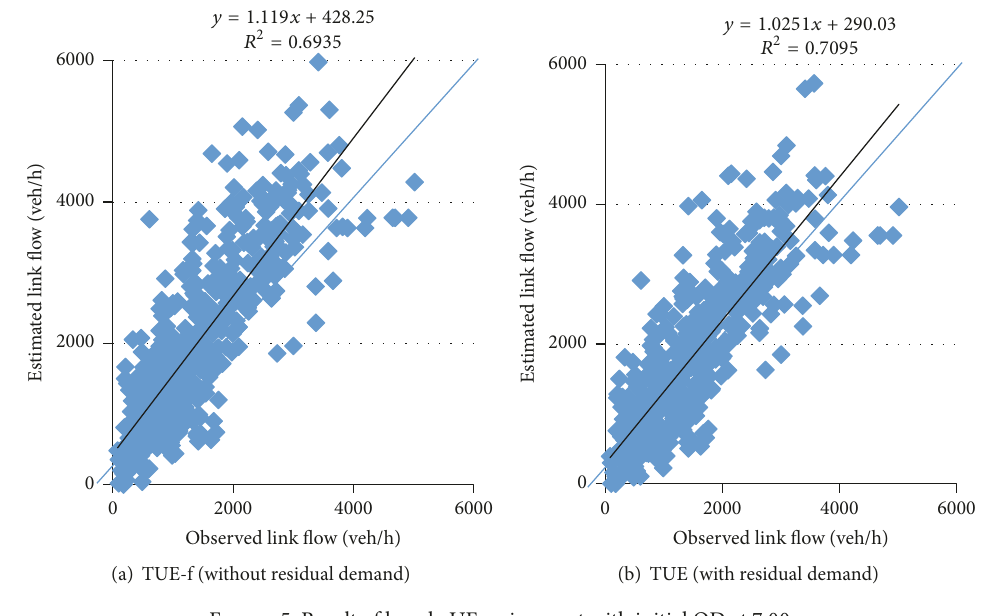
Figure 5: Result of hourly UE assignment with initial OD at 7:00.